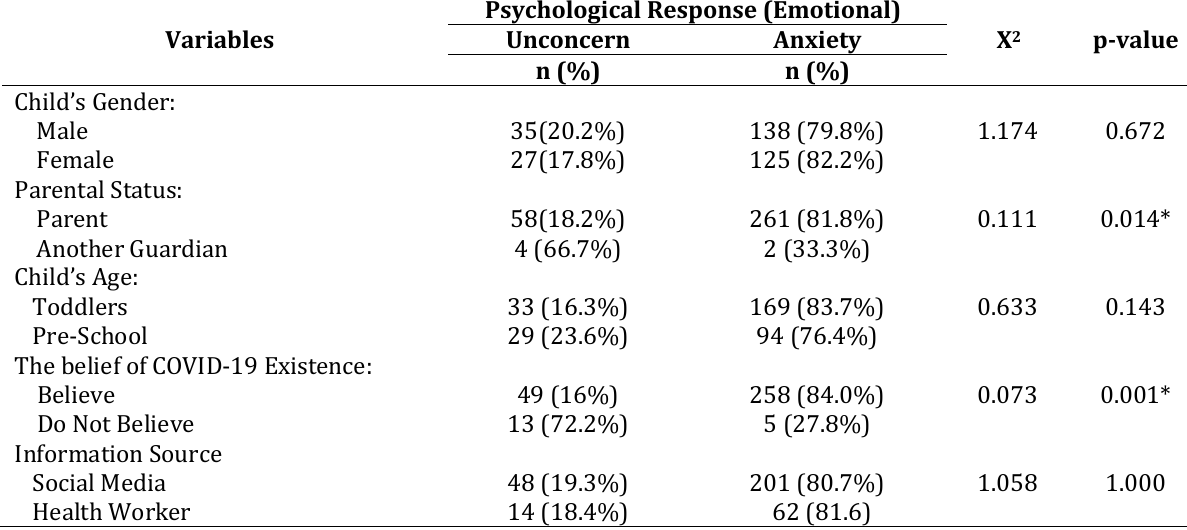
Table 2. The Relationship between Respondent Status and the Psychological (Emotional and Social) Response of Parents during the COVID-19 Pandemic (N=325)